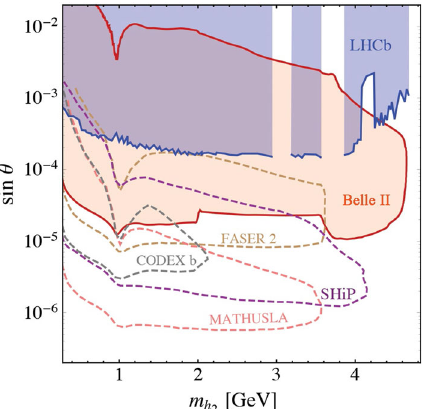
Fig. 4 Combined sensitivity of the Belle II experiment to displaced vertices of h 2 including both B → Kh 2 and B → K ∗ h 2 and decays of h 2 to (ππ + K K ),μ + μ − ,τ + τ − are shown with the filled red region, and compared to the search limit of LHCb [26] (shaded blue) and projected sensitivities by other proposed experiments, Mathusla [33] (pink), SHiP [34], CODEX b [35] (gray) and FASER 2 [36]